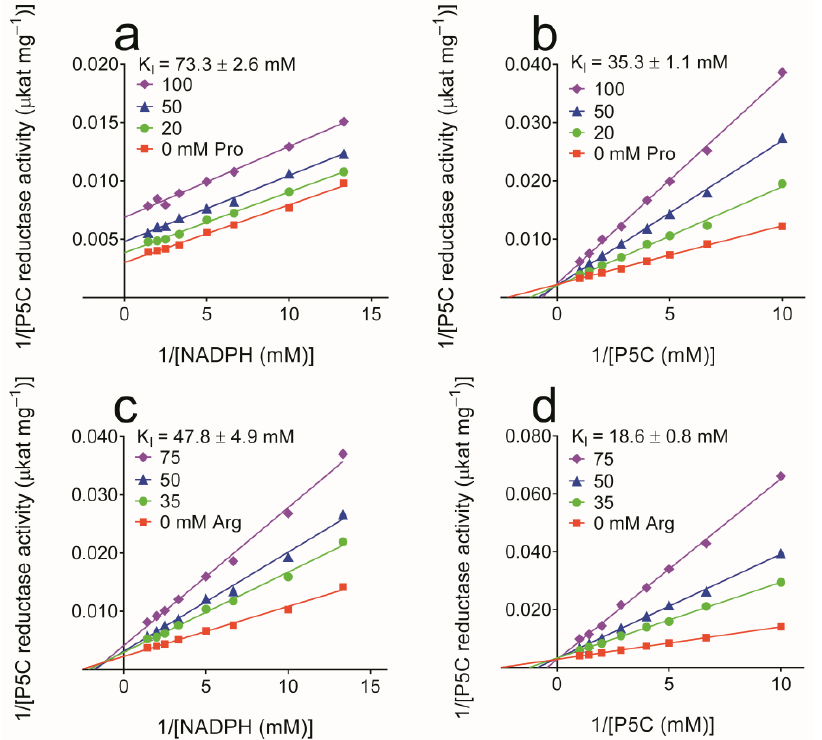
Figure 5. Kinetic analysis of the inhibition brought about by proline and arginine on the activity of yeast P5C reductase. Enzyme affinity was evaluated in the absence or in the presence of increasing concentrations of either amino acid. In the case of proline, reduced K M and V max (parallel lines in Lineweaver–Burk plot; panel a ) and increased K M with unaffected V max (lines converging to the y-axis; panel b ) accounted for an inhibition of uncompetitive and competitive type with respect to NADPH and P5C, respectively. The same pattern as with NADPH was obtained with NADH at higher proline doses. Concerning arginine, the same inhibition type was found with P5C (panel d ). On the contrary, with NADPH K M increased while V max lowered (panel c ), suggesting a mixed-type inhibition. The resulting K I values are indicated, with that for proline against NADH equal to 534 ± 26 mM. The results are the mean over 3 technical replications. The whole experiment was repeated at least twice with different enzyme preparations, obtaining consistent results.